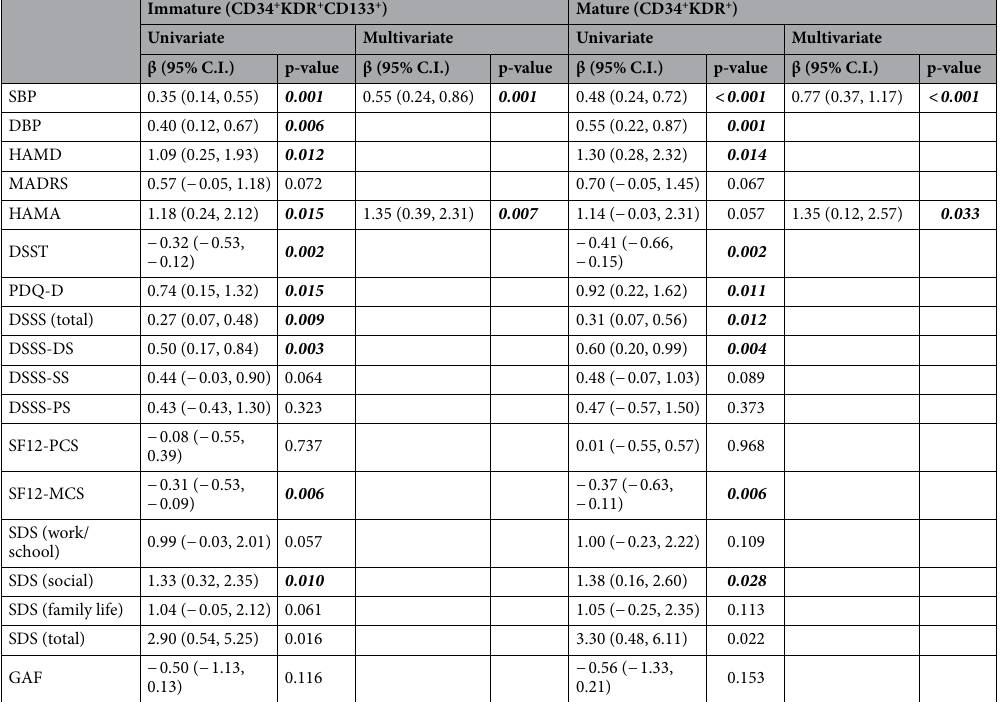
Table 2. Linear regression for the association of cEPC counts with clinical assessments related to major depressive disorder. Bold italicised values represent the p-values less than 0.05. cEPCs circulating